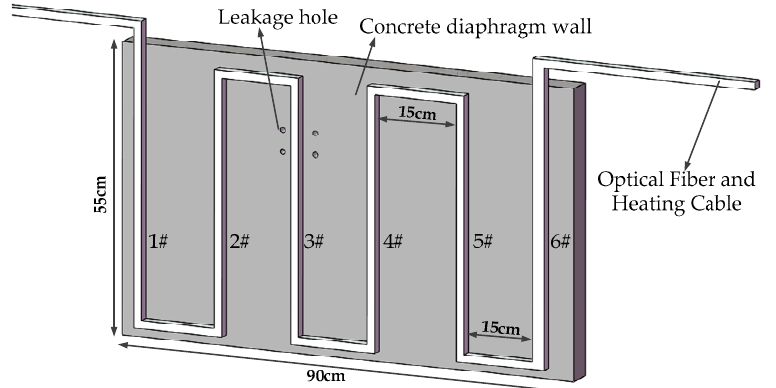
Figure 4. Optical fiber layout.